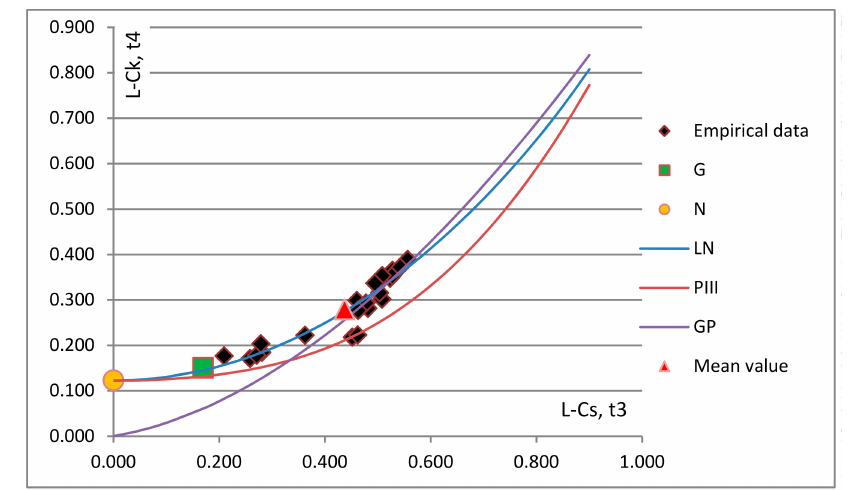
Figure 2. L-moments ratio diagram for flood volumes in the Pannonian